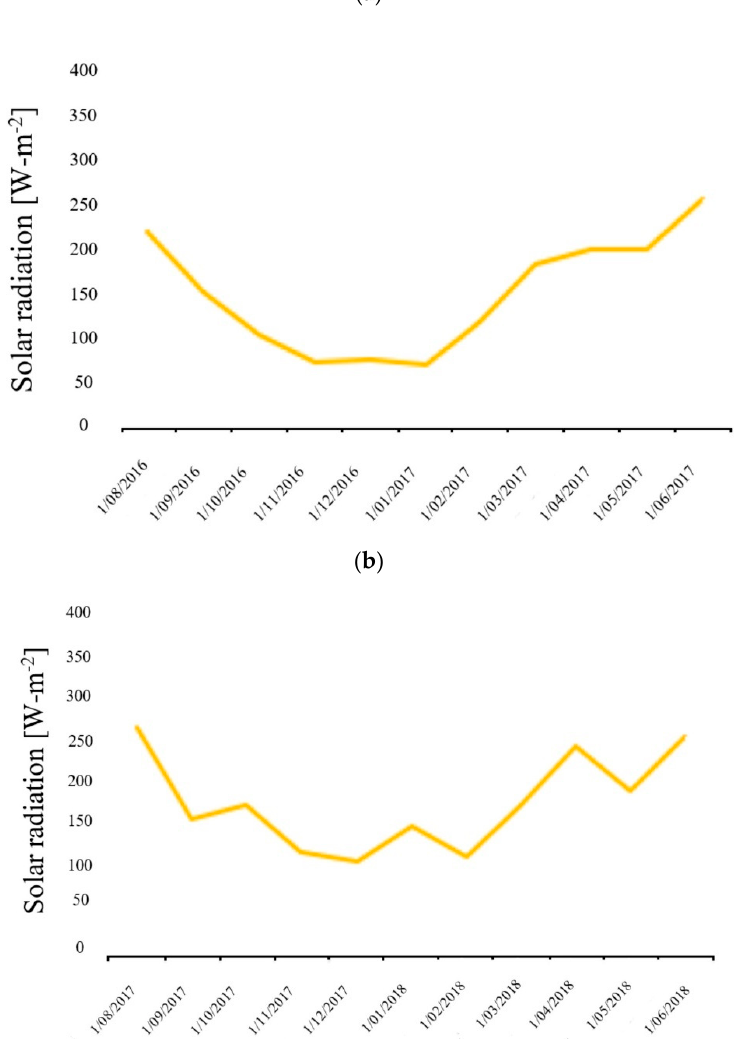
Figure 3. ( a ) Solar radiation 2016–2017. ( b ) Solar radiation 2017–2018.